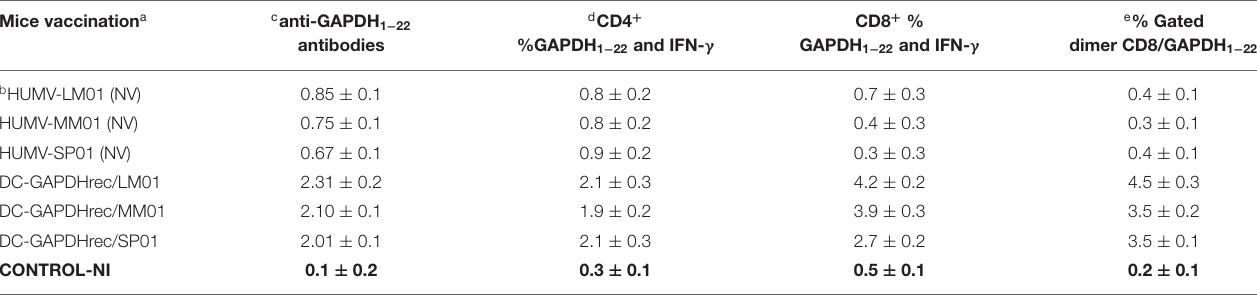
TABLE 2 | Specific immune responses elicited after vaccination of mice with DC-LM-GAPDHrec and challenge with LM (HUMV-LM01), MM (HUMV-MM01), or SP (HUMV-SP01). Mice vaccination a c anti-GAPDH 1 − 22